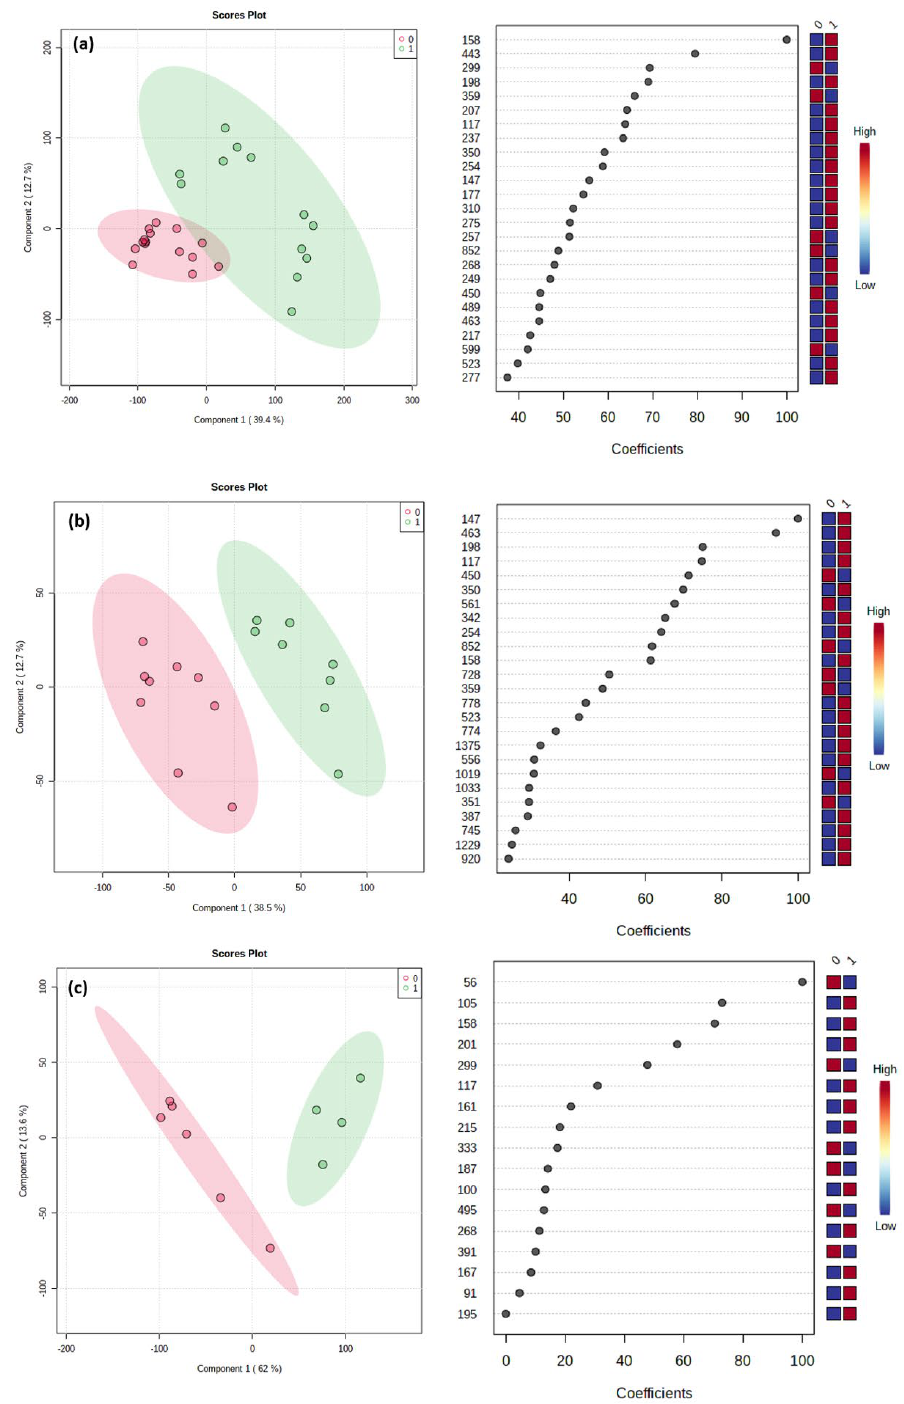
Figure 4. Partial least squares discriminant analysis (PLS-DA) results showing the comparison between OTU data acquired for ( a ) GP vs. GN, ( b ) GPF vs. GNF, and ( c ) GPM vs. GNM. On the left, the 2-D PLS-DA scores plots; on the right, the variable importance in projection plots. The most discriminating OTUs are shown in descending order of their coefficient scores. The color boxes indicate whether OTU is increased (red) or decreased (blue) in positive (1) vs. negative (0).